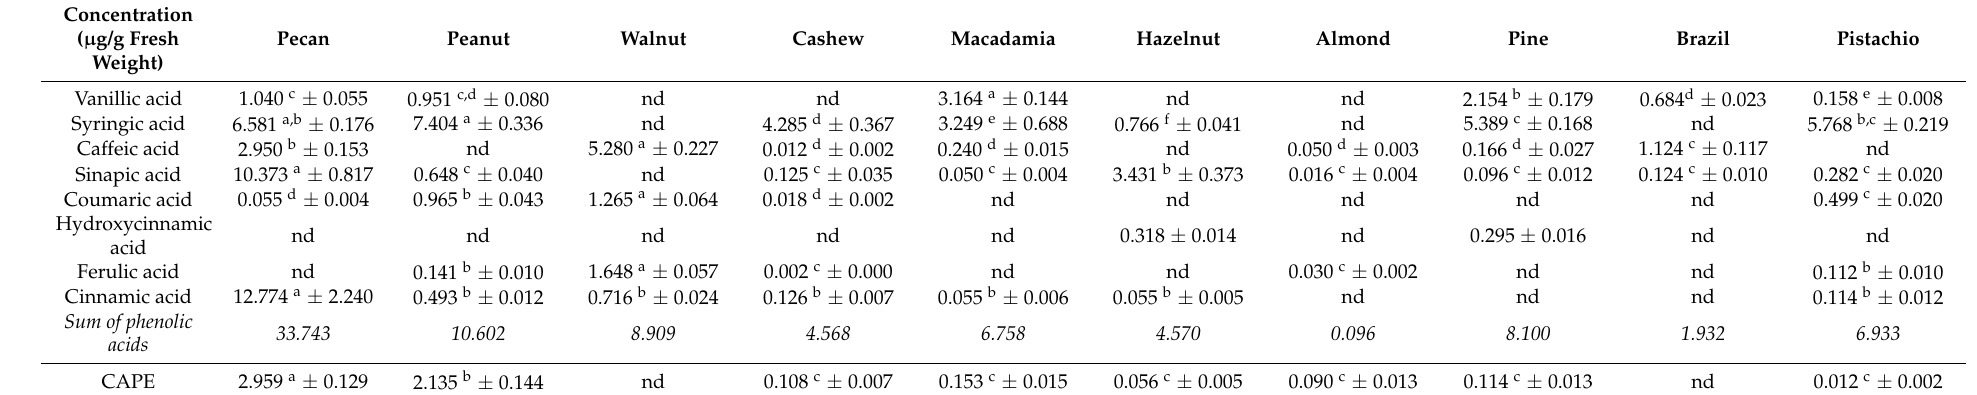
Table 2. The concentration of phenolic acids and CAPE in